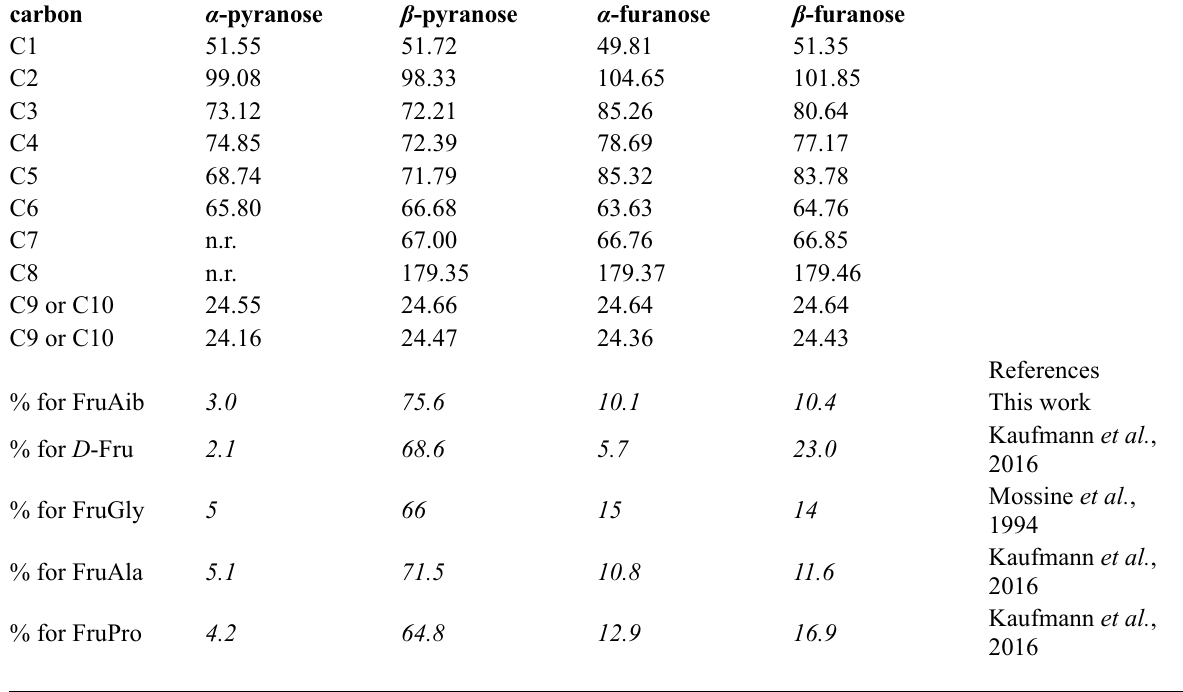
Table S1. C13-NMR spectrum and anomeric distribution of D-fructose-2-aminoisobutyric acid in D2O